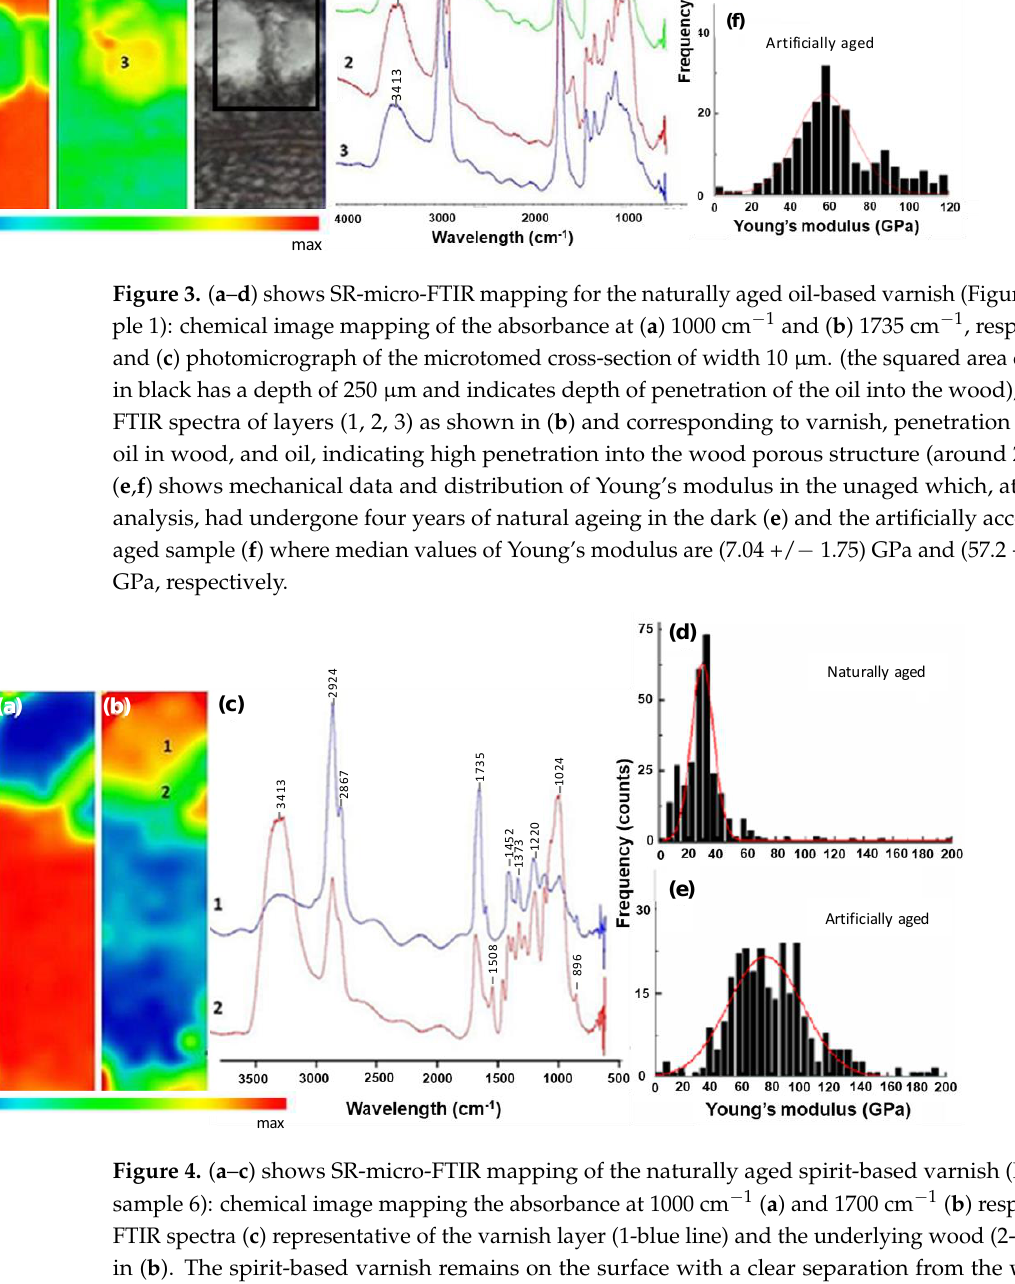
Figure 4. ( a – c ) shows SR-micro-FTIR mapping of the naturally aged spirit-based varnish (Figure 2 sample 6): chemical image mapping the absorbance at 1000 cm −1 ( a ) and 1700 cm −1 ( b ) respectively. FTIR spectra ( c ) representative of the varnish layer (1-blue line) and the underlying wood (2-red line) in ( b ). The spirit-based varnish remains on the surface with a clear separation from the wood as shown by the difference in spectra for layers 1 and 2. ( d , e ) shows mechanical data and distribution of Young’s modulus in naturally aged (4 years) ( d ) and artificially accelerated aged ( e ) samples where median values of Young’s modulus are 29.7 +/− 3.1 GPa and 75.7 +/ − 9.1 GPa, respectively.